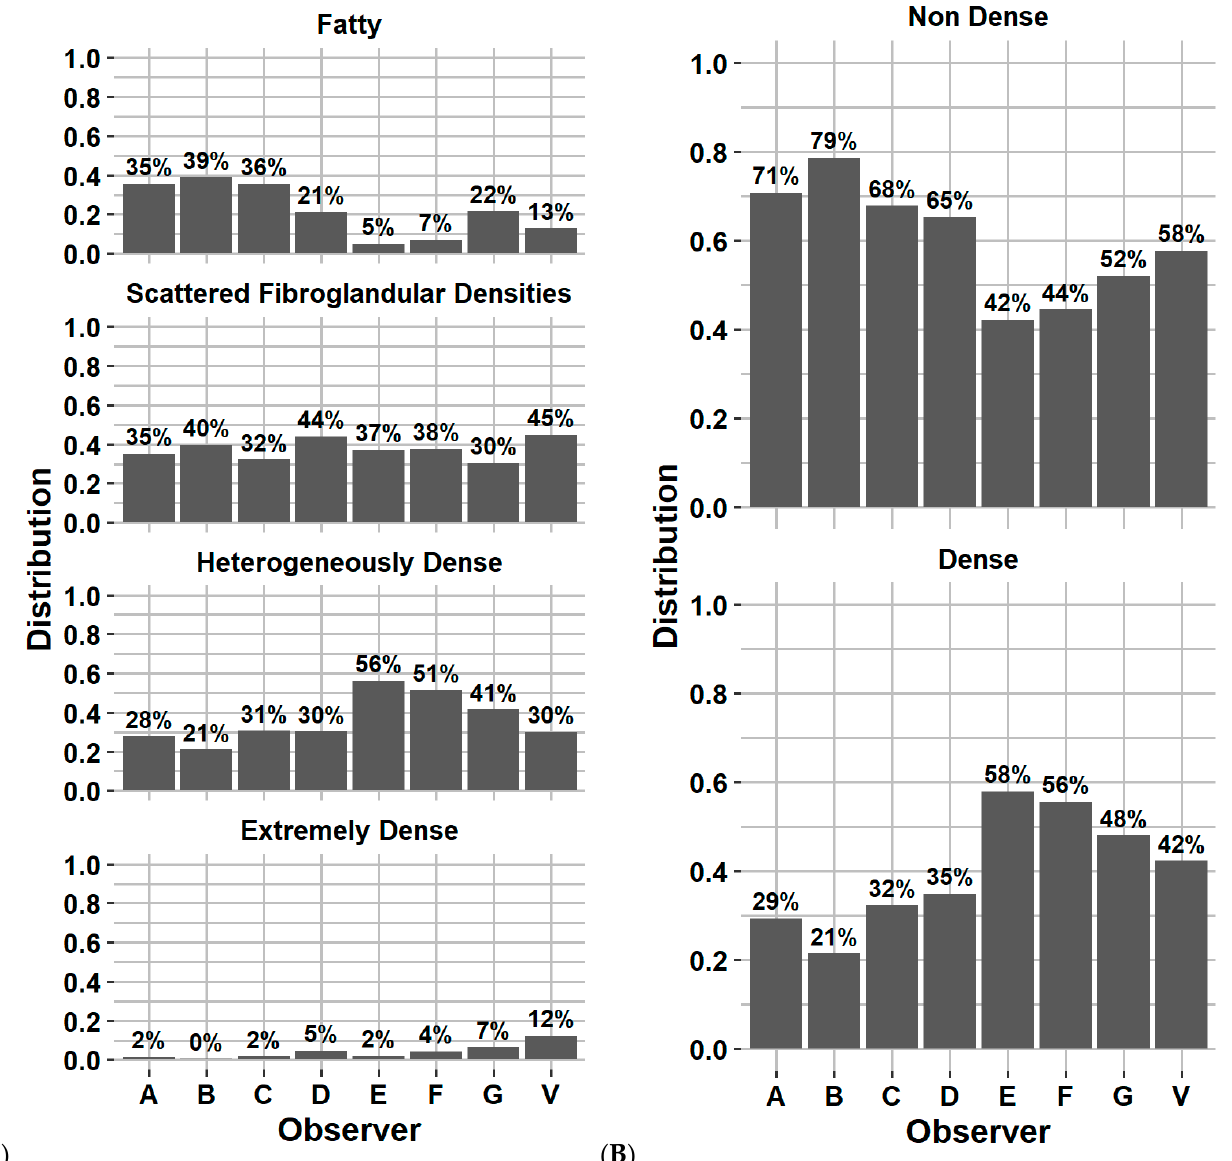
Figure 3. Distribution of breast density category assignment by each observer and Volpara software for ( A ) 4 categories and ( B ) 2 categories, on the first screening year of the test dataset. Physician experience in years of service: A = 8, B = 13, C = 8, D = 9, E = 5, F = 20 and G = 22 years. V = Volpara Density Algorithm 3.4.1 (Volpara Health Technologies, Wellington, New Zealand).